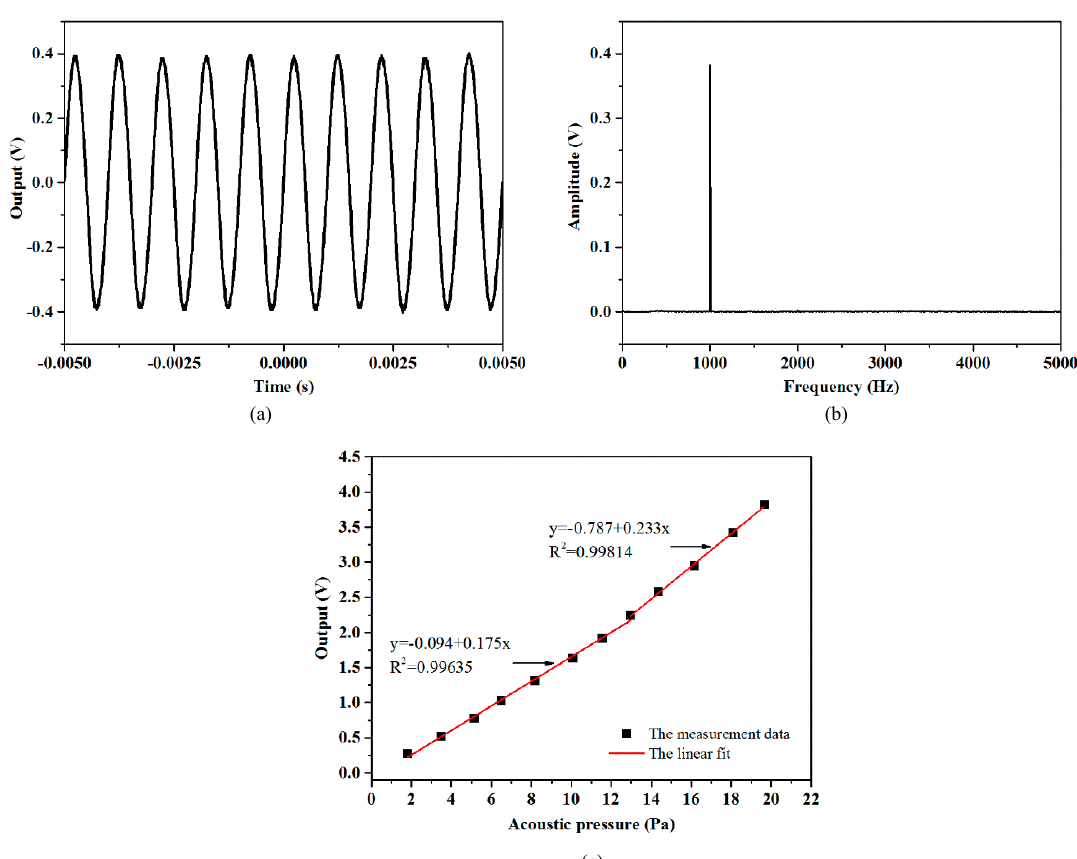
Figure 6. Response of the sensor measured with an acoustic signal of 1 kHz frequency: (a) time domain signal; (b) FFT of the time domain signal; (c) the relationship between the acoustic pressure and the sensor’s output.